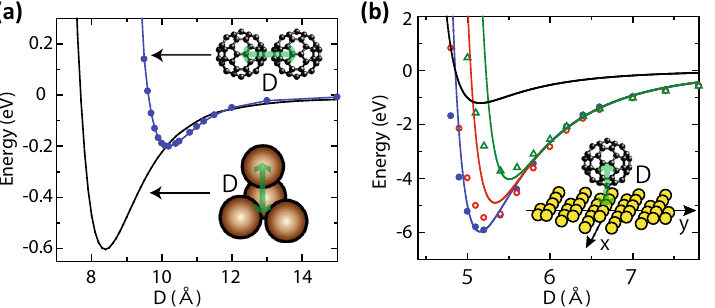
Figure 8. Variations of interaction energies. ( a ) The variations of C 60 –C 60 interaction energy of a dimer and a tetramer with respect to their distance D . ( b ) Variations of the interaction energy between the C 60 and tungsten surface. See the Method section for